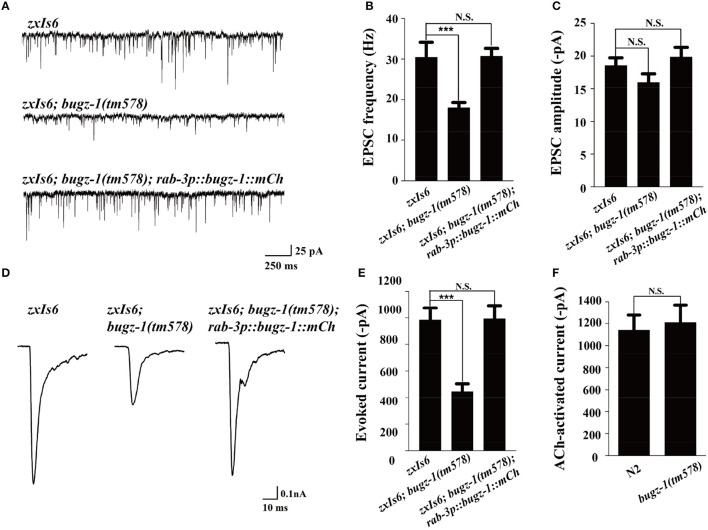
BuGZ-1 regulates neurotransmitter release at NMJs. (A–C) Recording of endogenous excitatory postsynaptic currents (EPSC) from adult body wall muscles of the indicated genotypes. zxIs6 [unc-17p::chop-2(H134R)::yfp, lin-15(+)]. Representative traces (A) and summary data for endogenous EPSC frequency (B) and EPSC amplitude (C) are shown. n ≥ 15. (D,E) Recording of photo-evoked EPSCs from adult body wall muscles of the indicated genotypes. ChR2-expressing cholinergic motor neurons were photo-activated by 100 ms blue light. Representative traces (D) and summary data (E) are shown. n ≥ 10. (F) Acetylcholine-induced currents in body muscles of mutant were indistinguishable from wild type. n ≥ 10. For each genotype, independent experiments were carried out in different animals. Values that significantly differ from controls are indicated (***p < 0.001 by two-tails Student's t-test). N.S. indicates no significant difference from control. Error bars represent SEM.